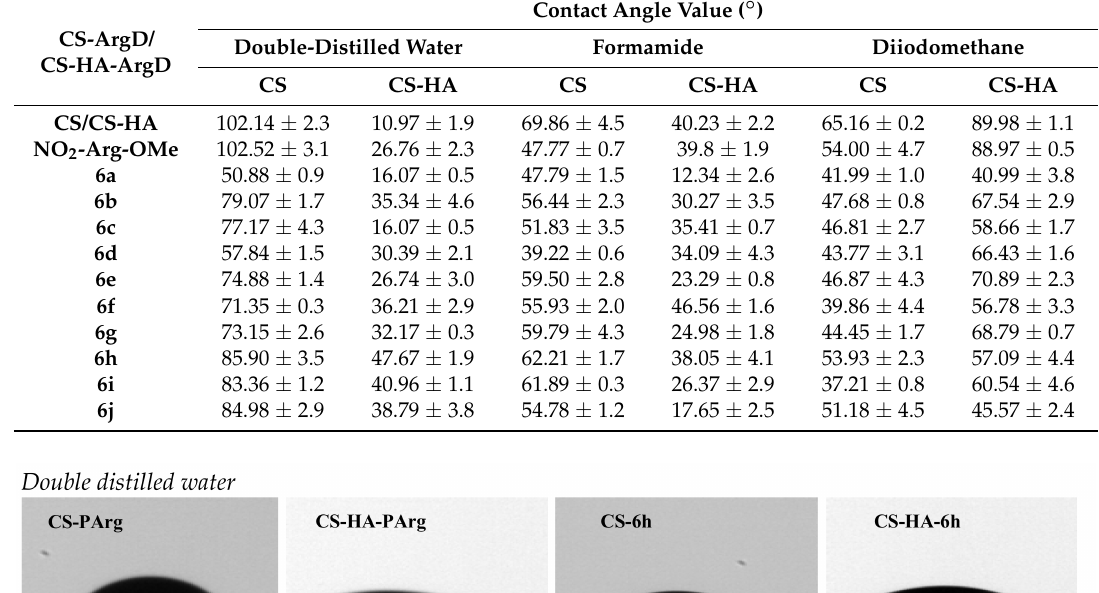
Table 1. The contact angle values recorded for CS-ArgD and CS-HA-ArgD films.